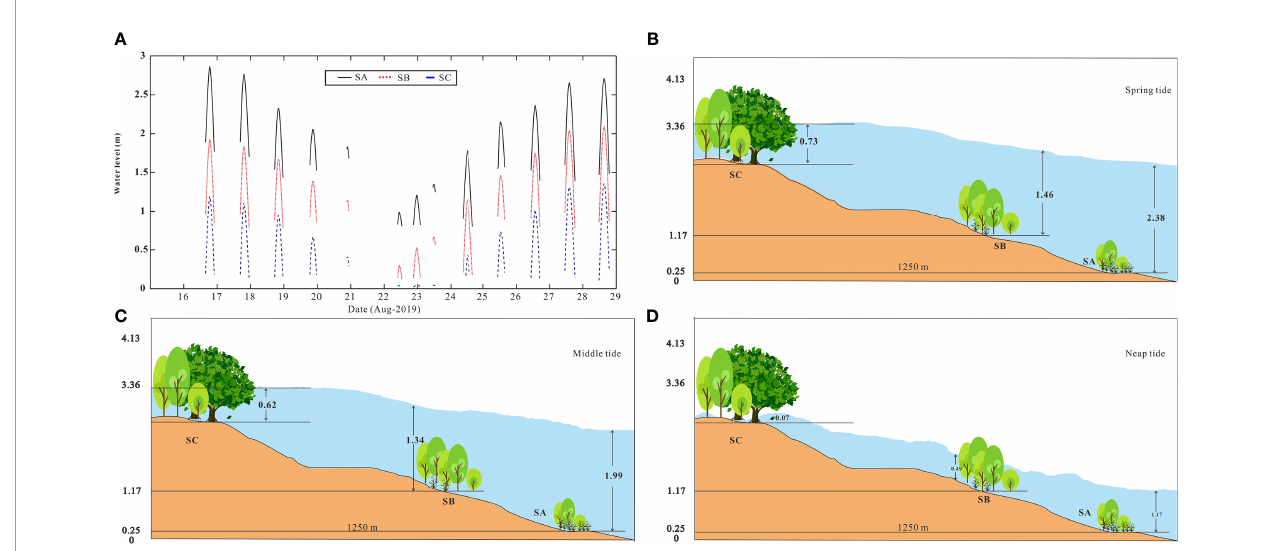
FIGURE 4 | (A) Hydrodynamic information obtained by the three tripods from the 16th to the 29th of August 2019. Black lines refer to the data captured by tripod SA. Red dotted lines refer to the data captured by tripod SB, and blue lines refer to the data captured by tripod SC; (B – D) show the inundation states of mangroves in the spring, middle, and neap tides, respectively.